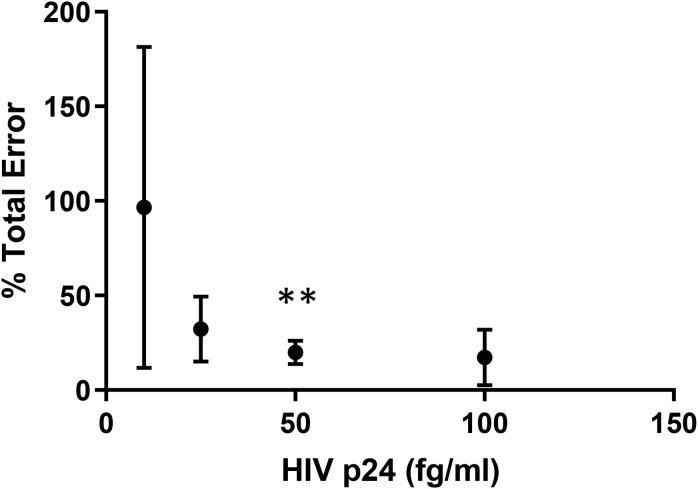
The lower limit of quantitation for the DEVO assay. Freshly isolated resting CD4 + T cells from an uninfected donor were stimulated with PHA and irradiated PBMC, then co-cultured with PHA blasts over the course of 19 days. On three separate, but not consecutive days, supernatant from day 8 and 12 were spiked with HIV p24 protein at different dilutions and assayed by Simoa. Bias, total error and % total error was calculated from replicate well values using the following formula: Bias = Average−ActualValue;TotalError = |Bias| + 2×StandardDeviation;%TotalError = TotalErrorActualValue×100. The concentration with <20% total error was determined to be 49.21fg/ml**. This value was used as the DEVO lower limit of quantitation.